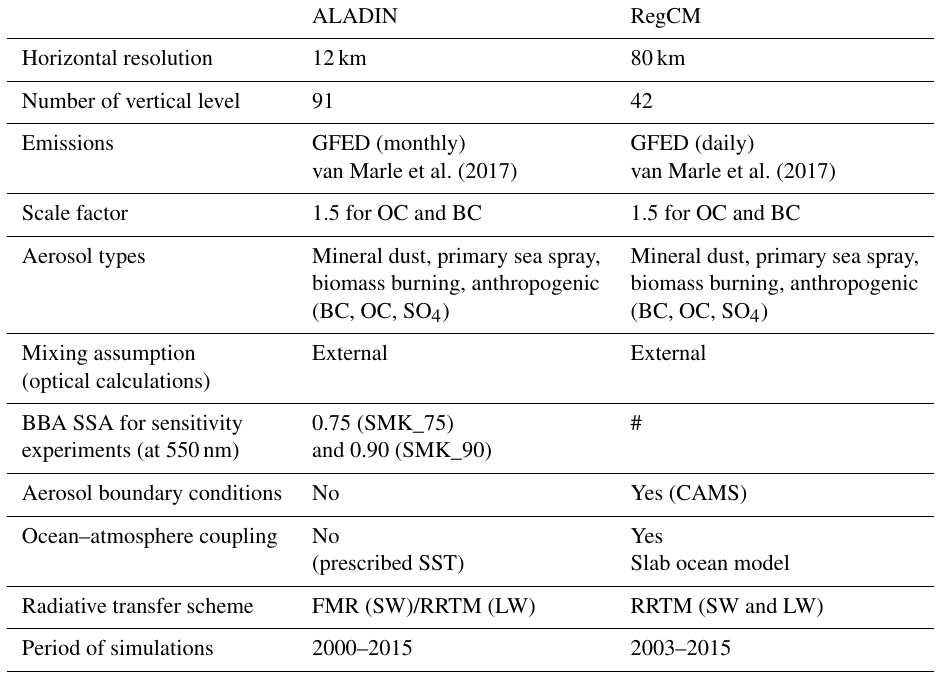
Table 1. RegCM and ALADIN regional climate model